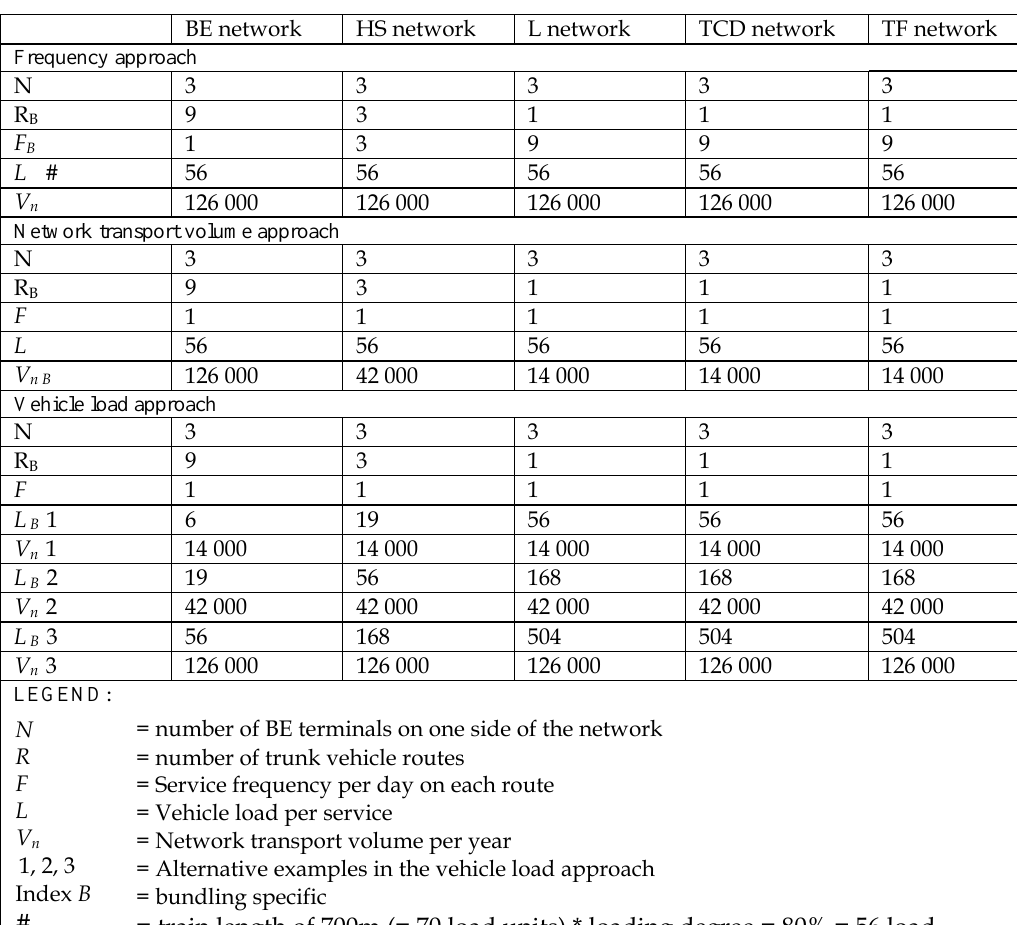
Table 1. Quantities for the example of Figure 1 in the frequency, network transport volume or vehicle load